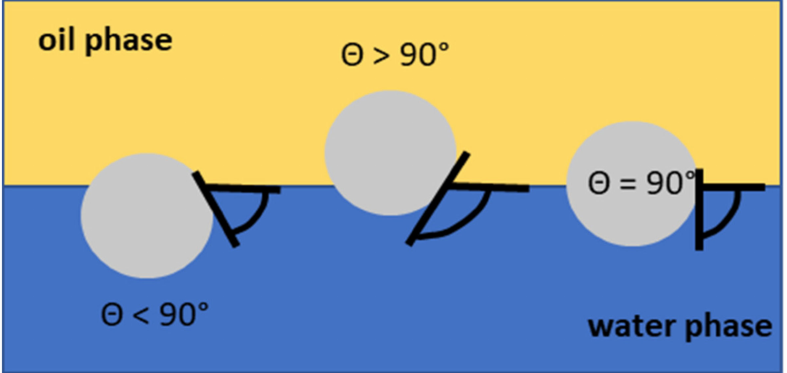
Figure 1. Examples of Pickering particles behavior on water–oil interface, determined by the wetta- bility of solid particles.